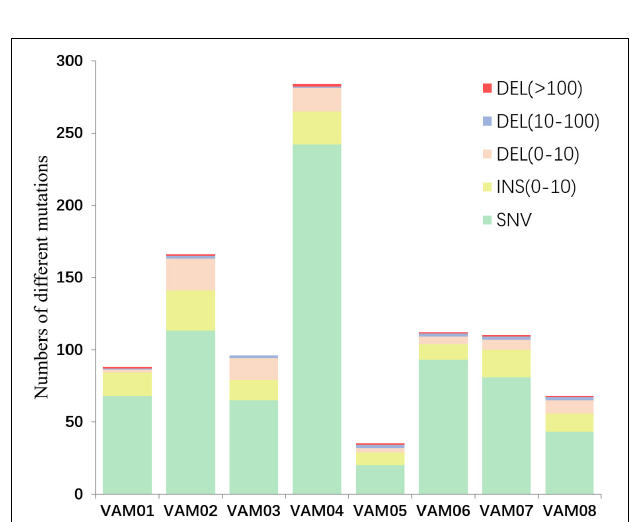
FIGURE 3 | Biochemical profiles of eight PRM strains and the primary strain E06333 from V. alginolyticus revealed by Biolog assays. The purple circles in boxes represent a positive reaction (growth). The purple circles with blue background represent six PRM strains obtained the ability of utilizing α -Hydroxy-Butyric Acid. The boxes with light green background represent five tests of chemical sensitivity.